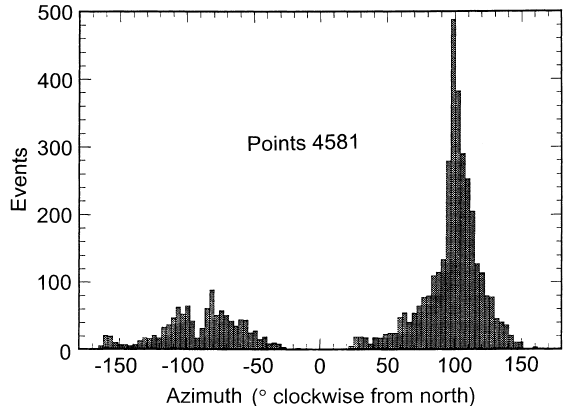
Fig. 10. Histograms of trace azimuth for the newly defined MEDs. The background events seen in Fig. 7 have been removed